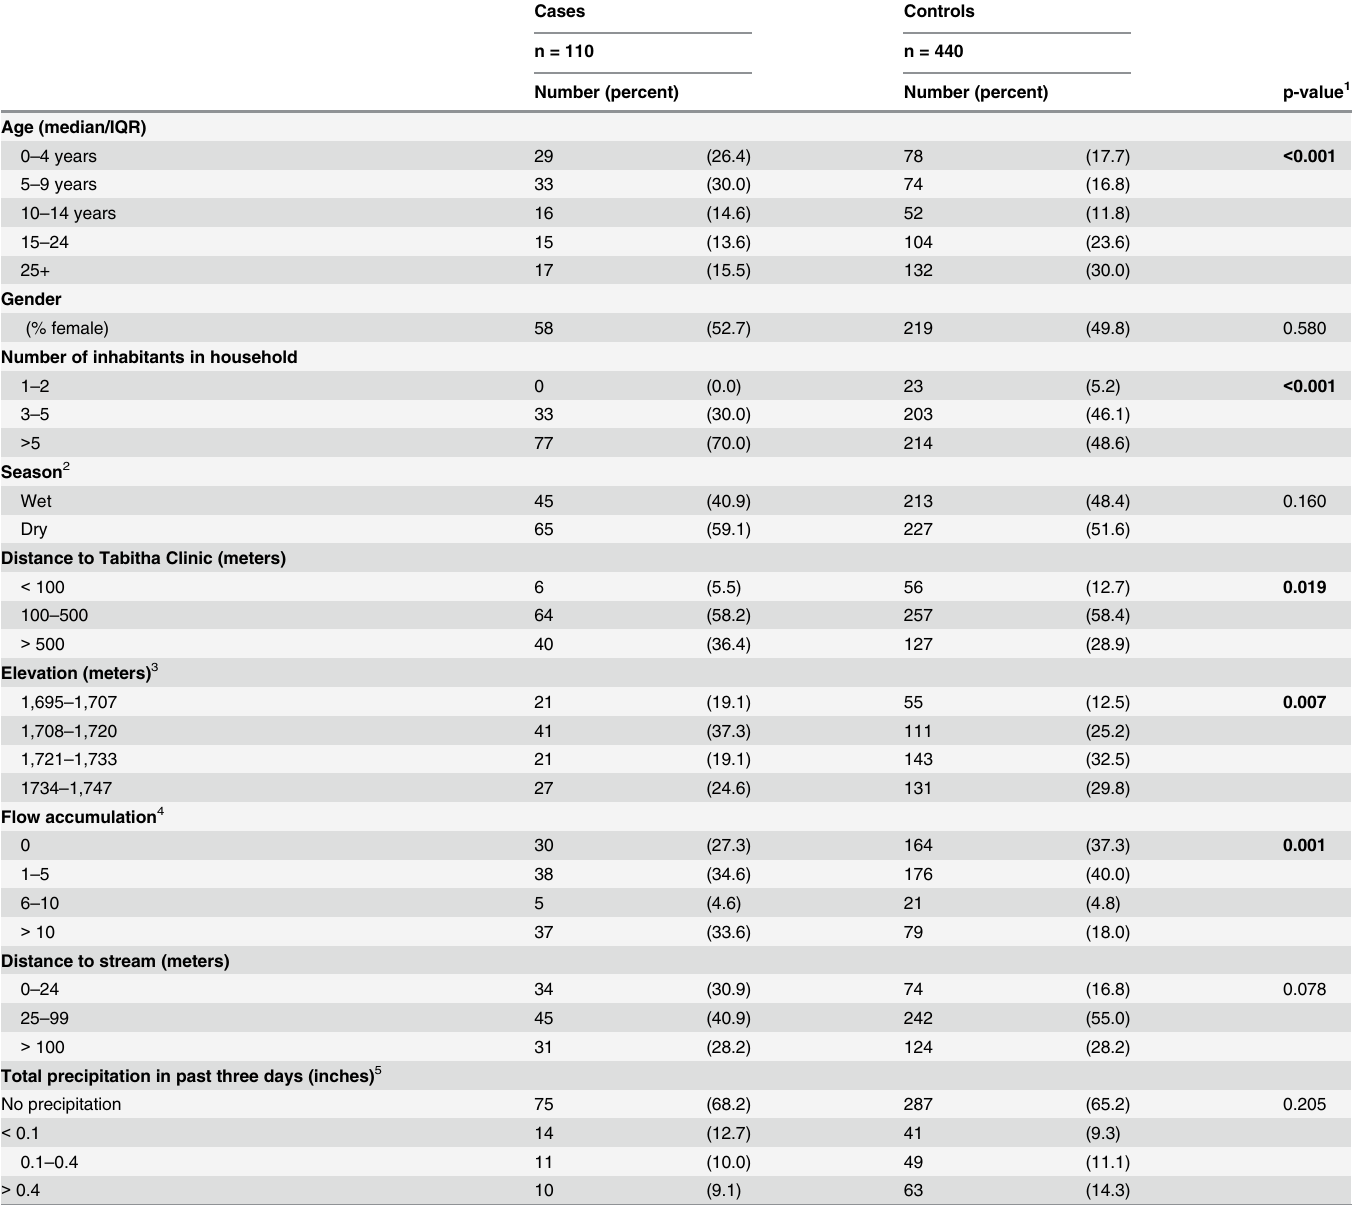
Table 1. Demographic and environmental variables by case-control